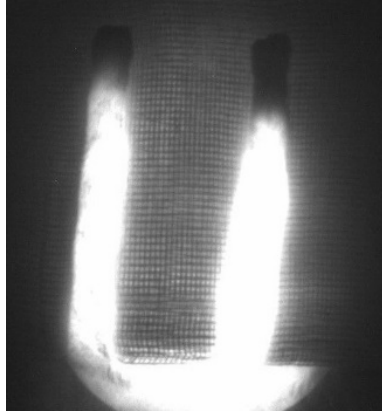
Figure 4. Indocyanine green angiography after flap harvest in group 2